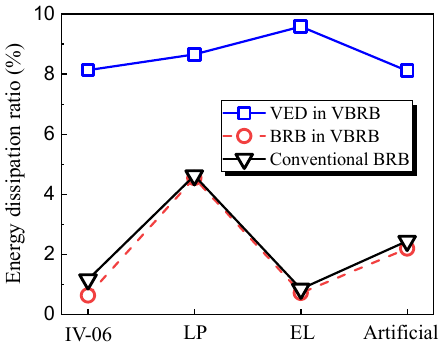
Figure 11. Seismic energy analysis (Imperial Valley-06 case, PGA = 70 cm/s 2 ): ( a ) energy distribution (VBRB-BF); ( b ) energy absorbed by components (VBRB-BF); ( c ) energy distribution (BRB-BF); and ( d ) energy absorbed by components (BRB-BF).